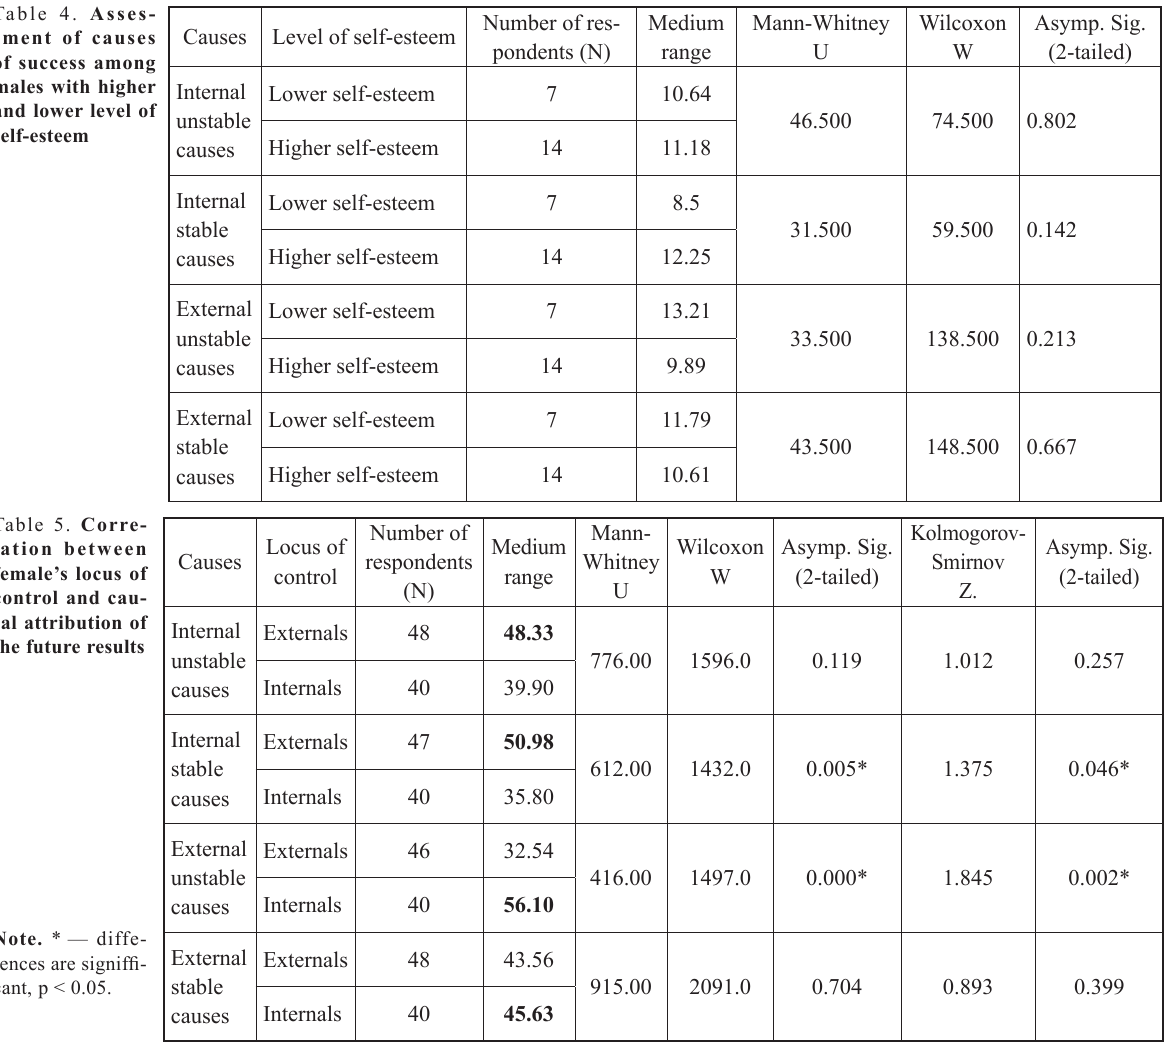
Note. * — diffe- rences are signif fi - cant, p <